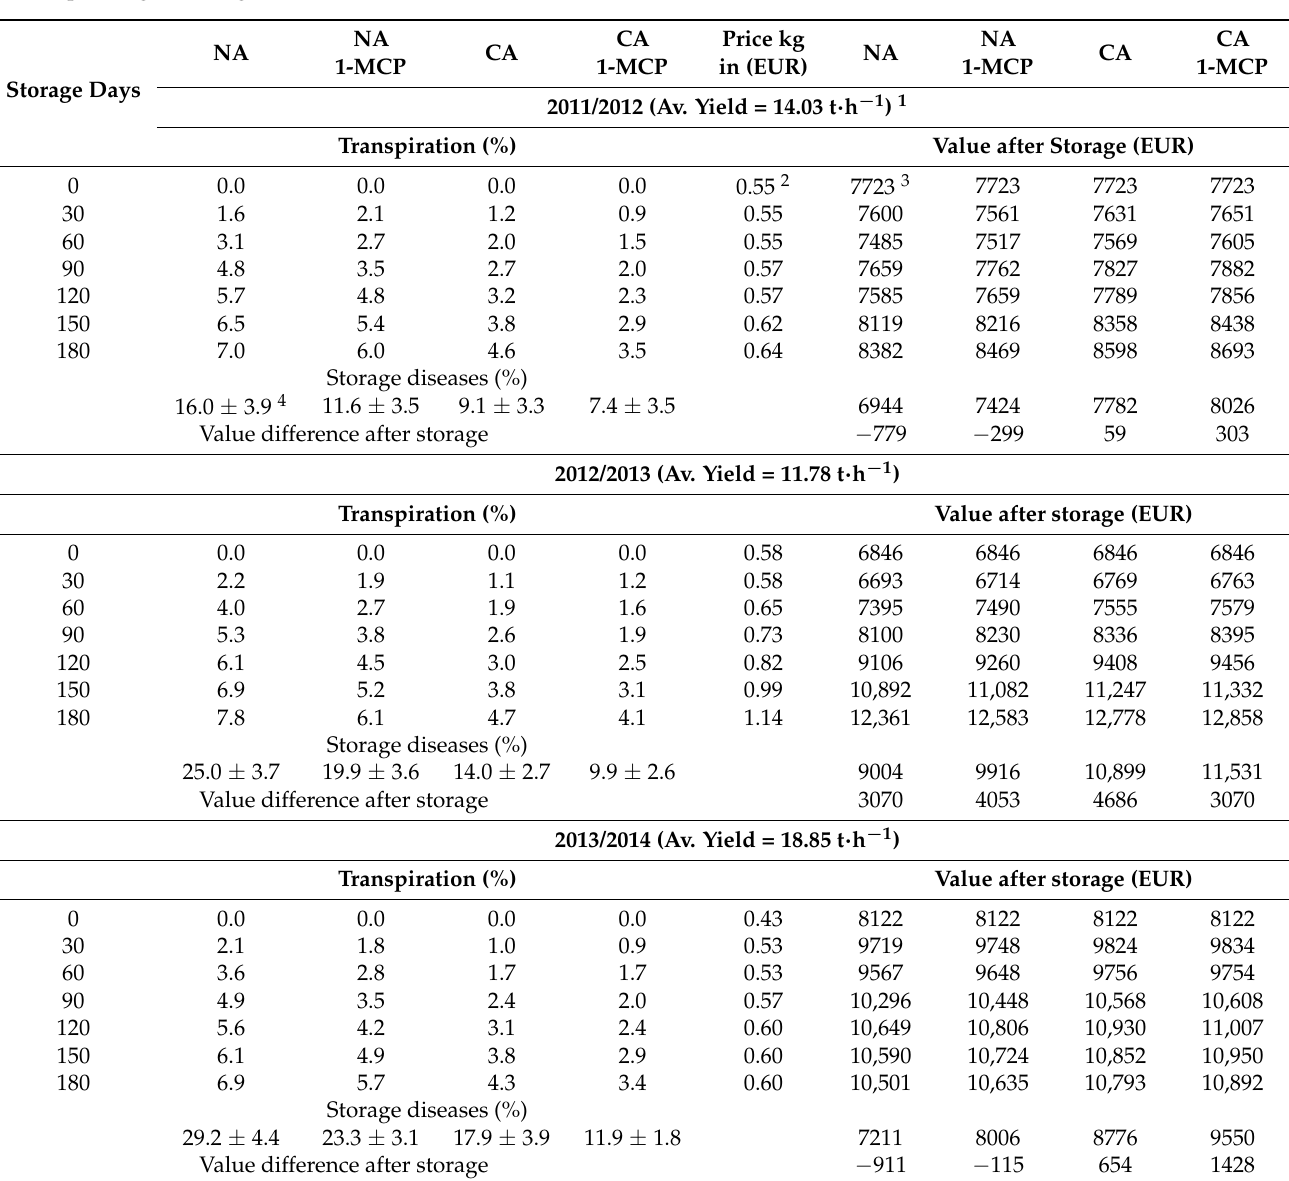
Table 8. Differences in revenues from the sale of the average pear yield in the EU at market prices in each year of the study, depending on storage